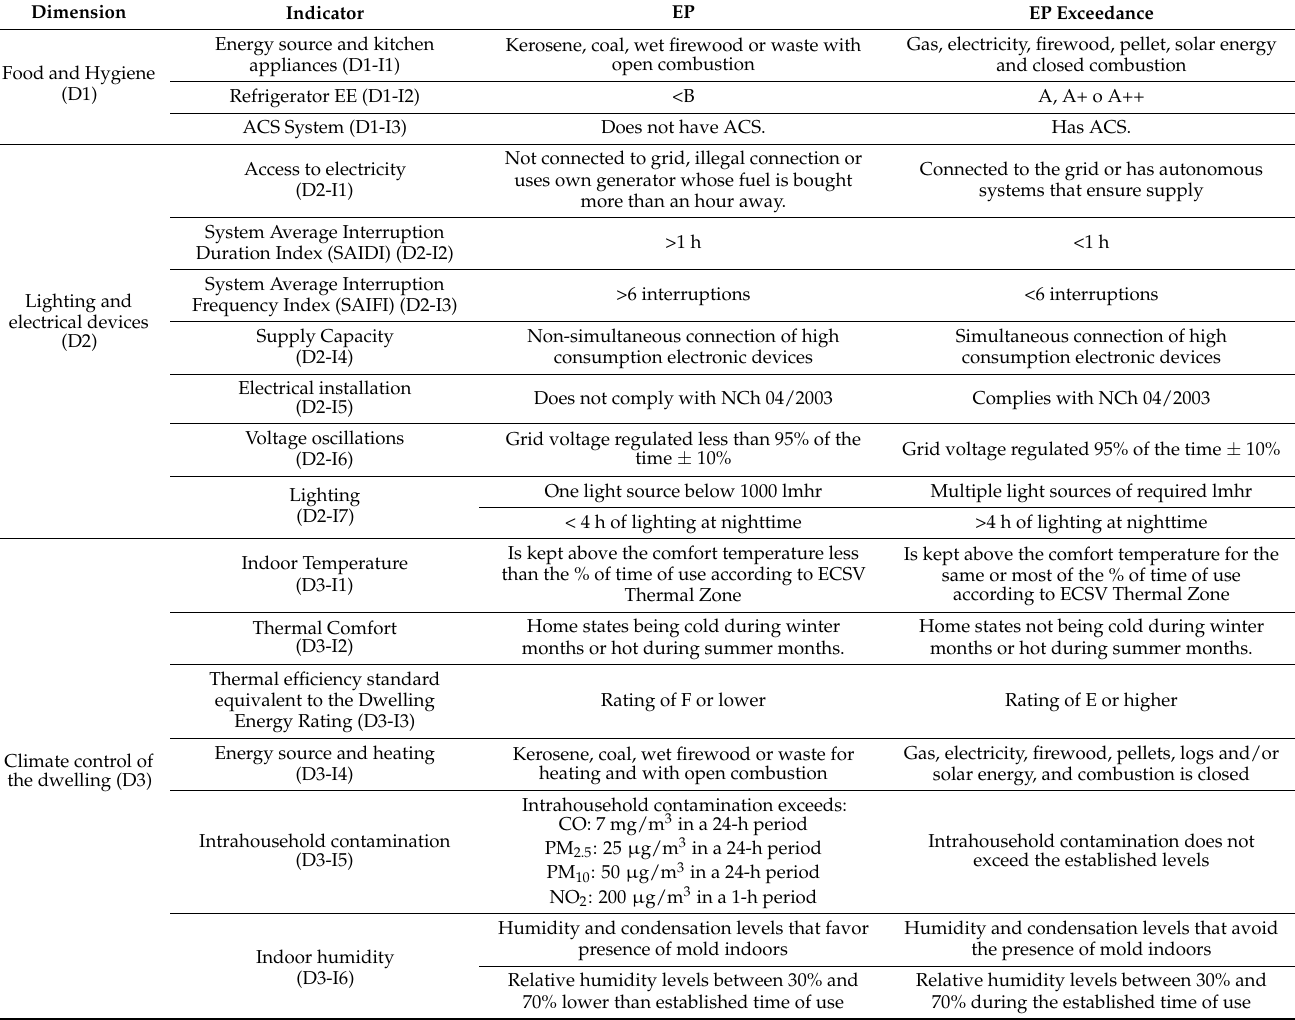
Table A1. Dimensions and thresholds of the Equitable Access to Quality Energy Standard, created by